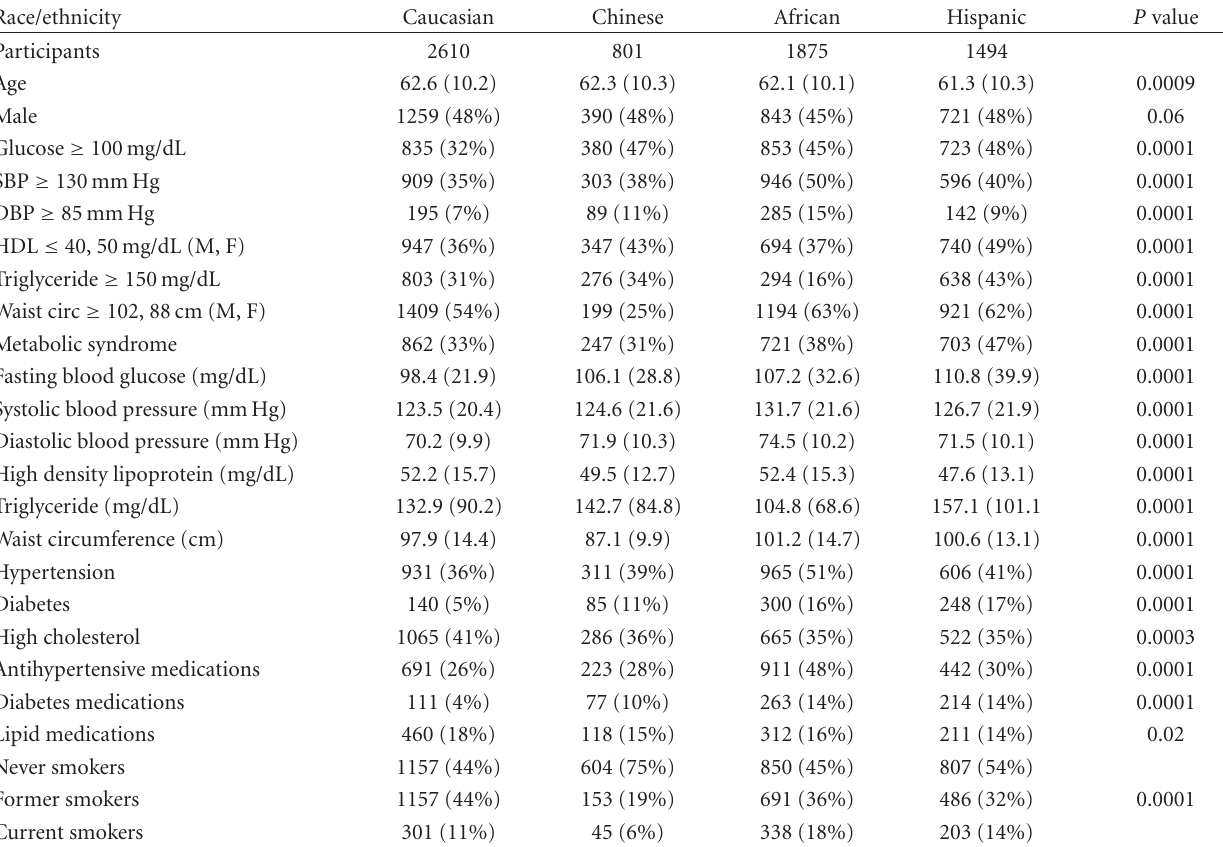
Table 1: Baseline Characteristics of the MESA cohort (2000–2002).